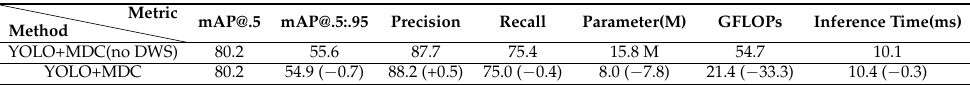
Figure 11. Multidilated rate convolution fusion structure (MDC-D). Table 5. Comparison of metrics without and with depthwise separable convolution